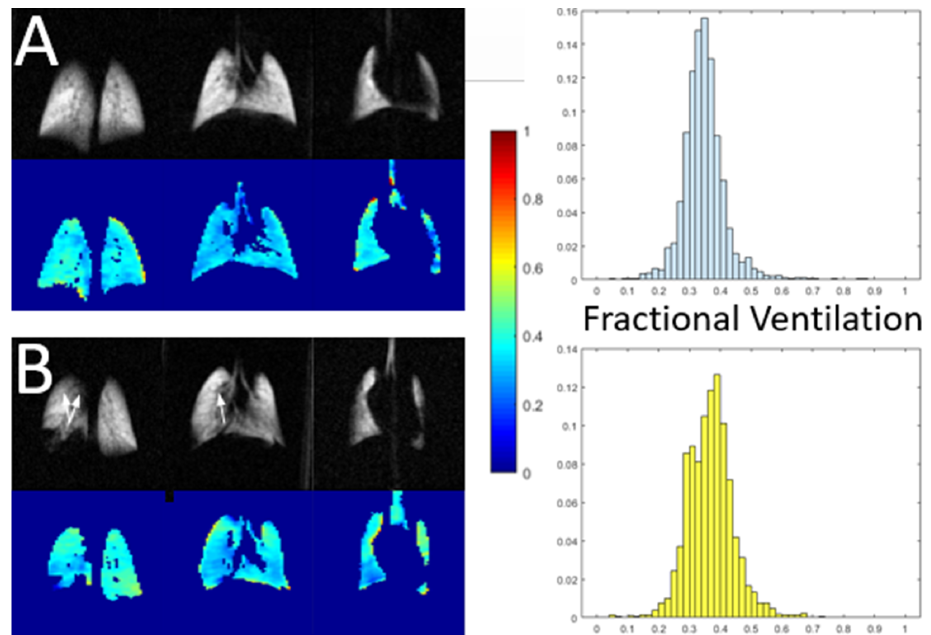
Figure 7. A comparison of local per-breath gas replacement efficiency in healthy ( A ) and tumor- bearing ( B ) lungs highlight the loss of ventilation in the tumor region (last row, lower left) as well as the changes to regional changes due to mechanical effects of the tumor throughout the organ (bottom row and accompanying histogram).